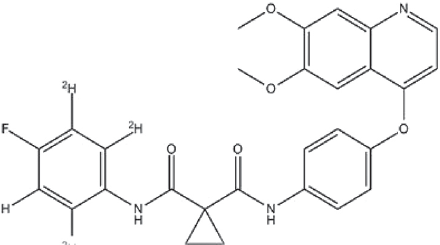
FIGURE 2 - Chemical structure of